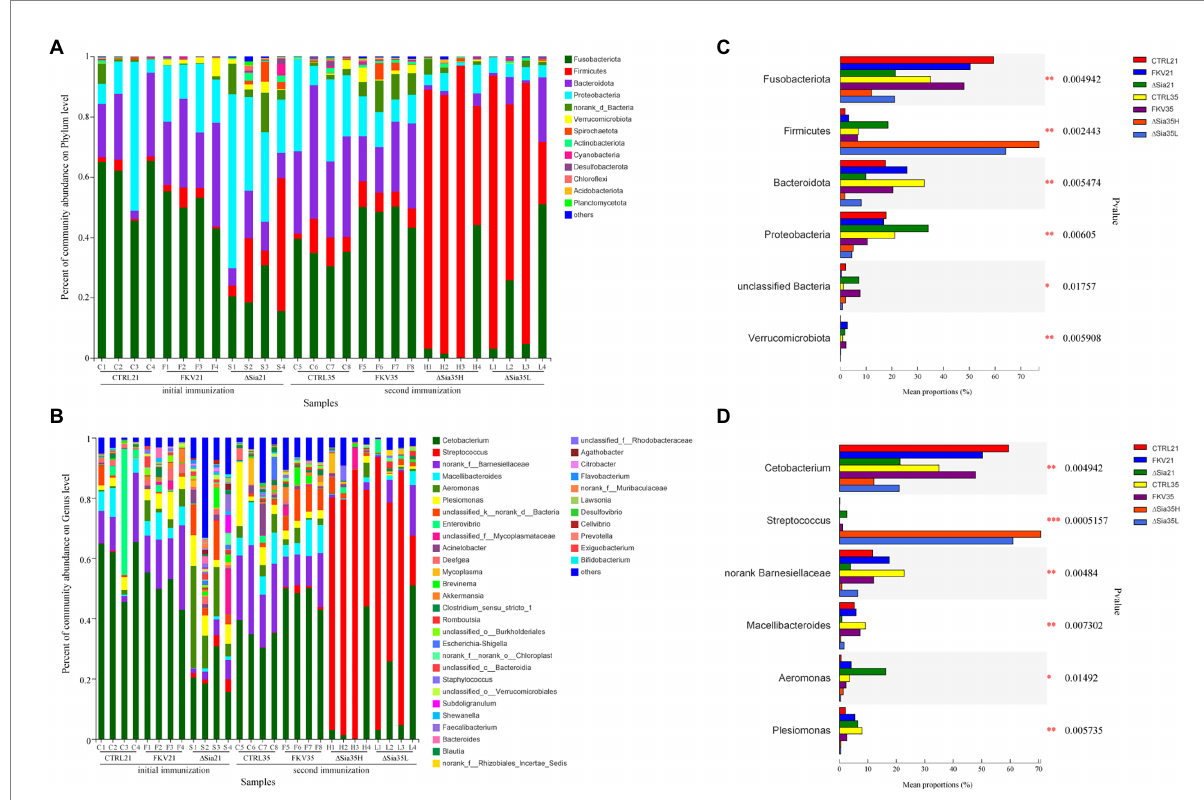
FIGURE 2 Community composition of samples from various groups at the (A) phylum level and (B) genus level. The horizontal axis shows the sample names, and the vertical axis shows the relative abundance of species. Species with abundance ratios of less than 0.01 in all samples were classified as others. Mean proportion of dominant phyla (C) and genera (D) in different groups. CTRL21 (C1–C4), control group at 21 dpiv; FKV21 (F1–F4), FKV group at 21 dpiv; ∆ Sia21 (S1–S4), LAV ∆ Sia group at 21 dpiv. CTRL35 (C5–C8), control group at 35 dpiv; FKV35 (F5–F8), FKV vaccine group at 35 dpiv (14 days after the second immunization); ∆ Sia35H (H1–H4), LAV ∆ Sia group with a high serum antibody response at 35 dpiv (14 days after the second immunization); ∆ Sia35L (L1–L4), LAV ∆ Sia group with a low serum antibody response at 35